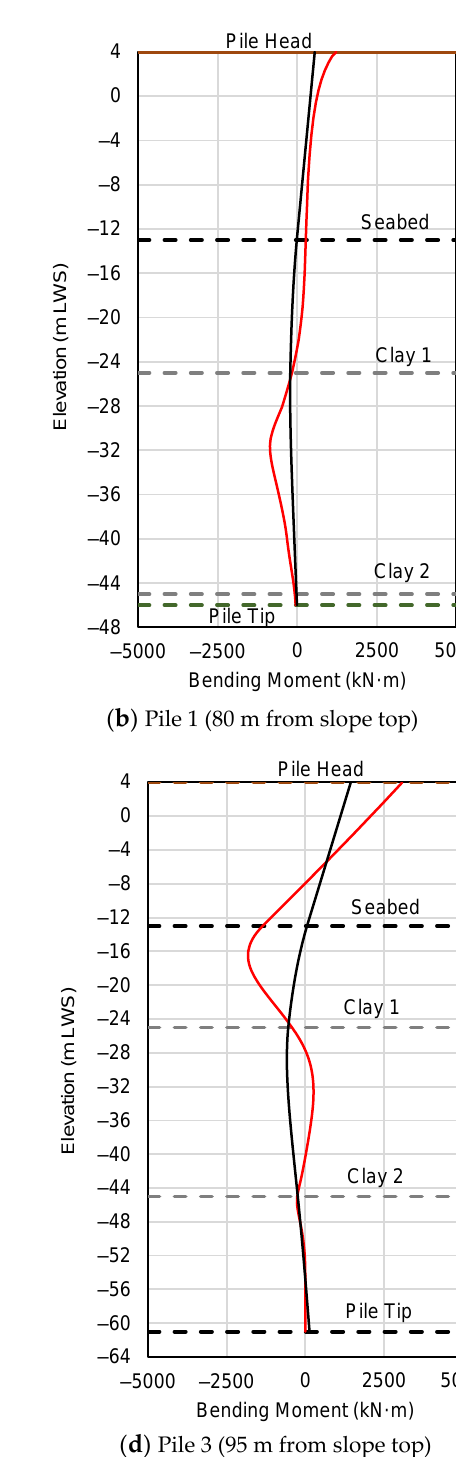
Figure 17. Bending moment distribution of the PSW considering the inertial and kinematic forces due to the ME waveform (Scenario 2).